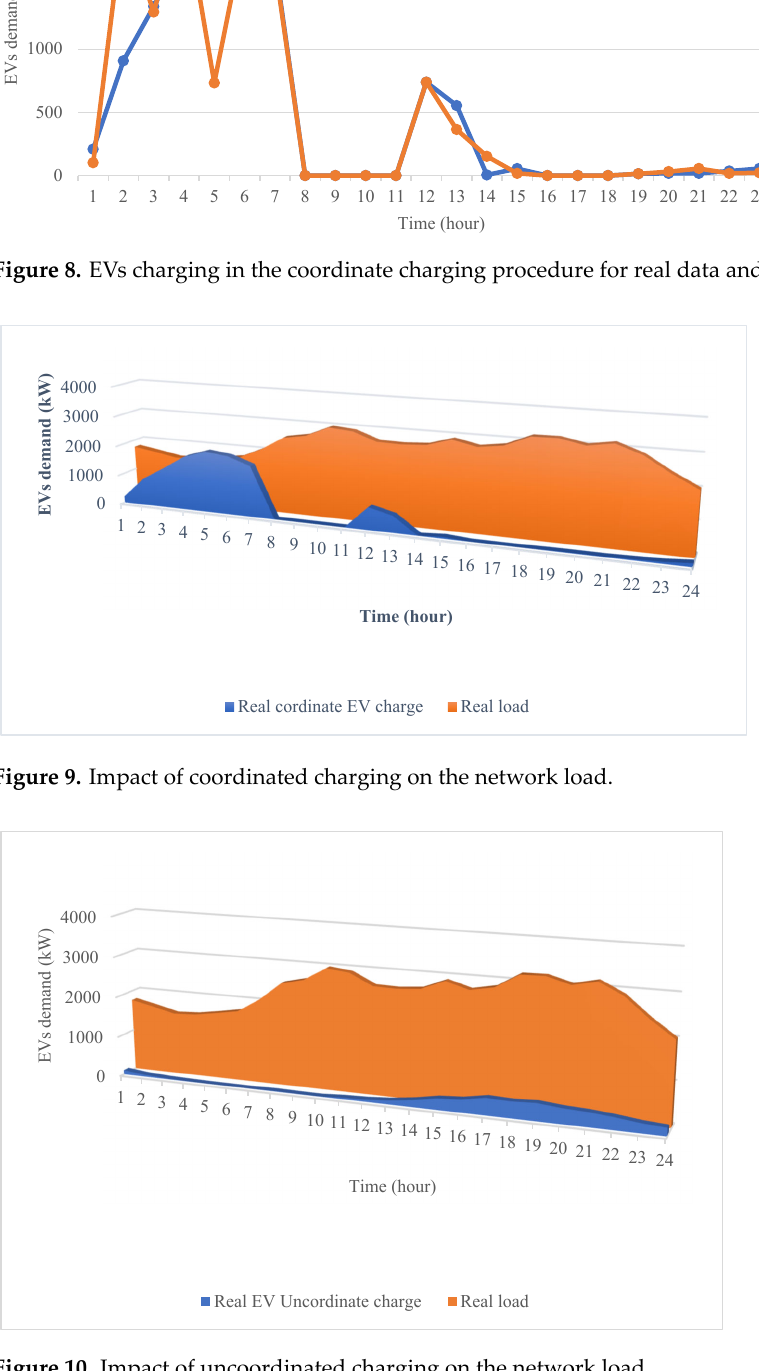
Figure 8. EVs charging in the coordinate charging procedure for real data and BLSTM method.